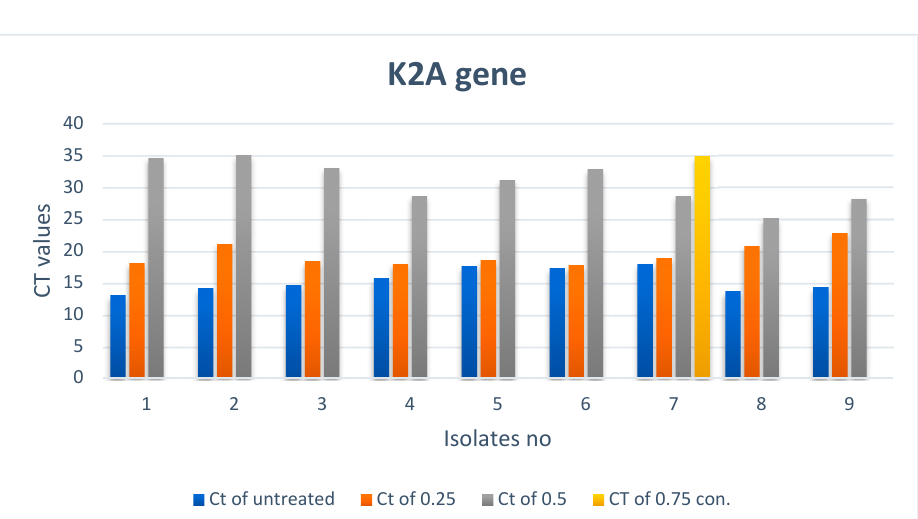
Figure 3. k2A gene expression in Klebsiella pneumoniae isolates treated with different concentrations of ZnO